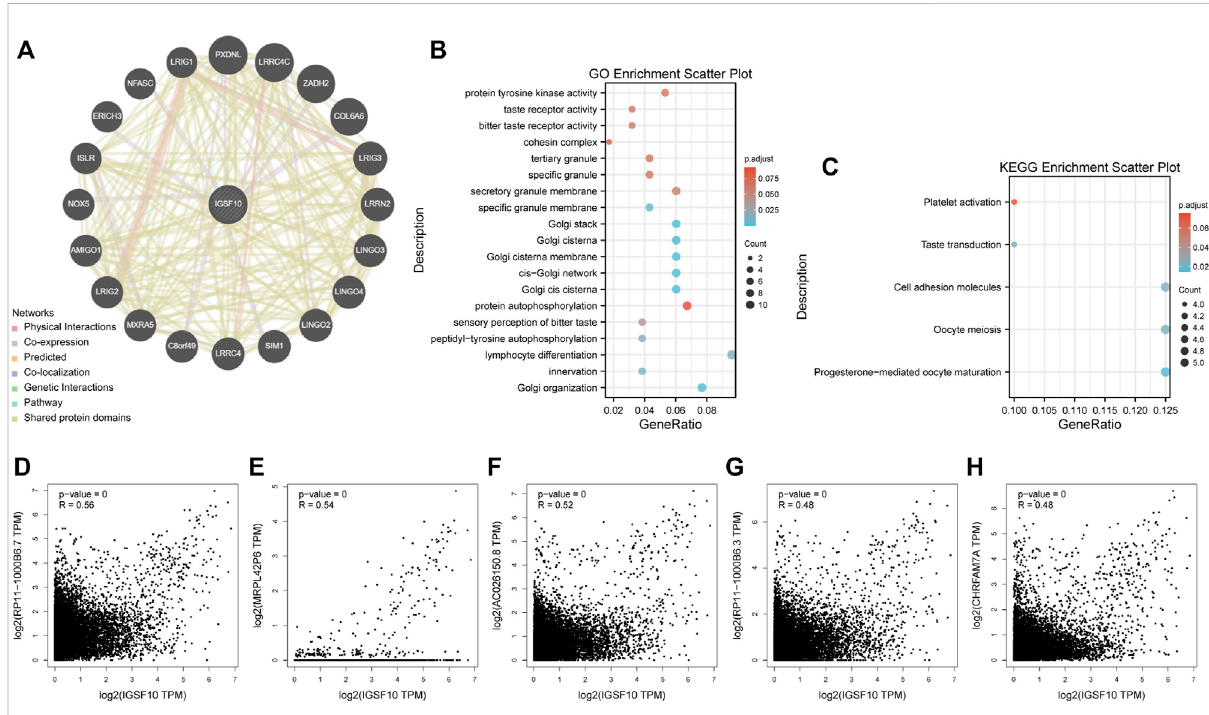
FIGURE 13 Enrichment analysis of IGSF10-interacted proteins and IGSF10 -related genes. (A) IGSF10-interacted proteins from the GeneMANIA database. (B) GOenrichmentanalysisbasedontheIGSF10-interactedproteinsand IGSF10 -relatedgenes. (C) KEGGenrichmentanalysisbasedontheIGSF10- interacted proteins and IGSF10 -related genes. (D – H) Scatter plots of expression correlations between IGSF10 and RP11-1000B6.7 , MRPL42P6 , AC026150.8 , RP11-1000B6.3, and CHRFAM7A in pan-cancer using the GEPIA2